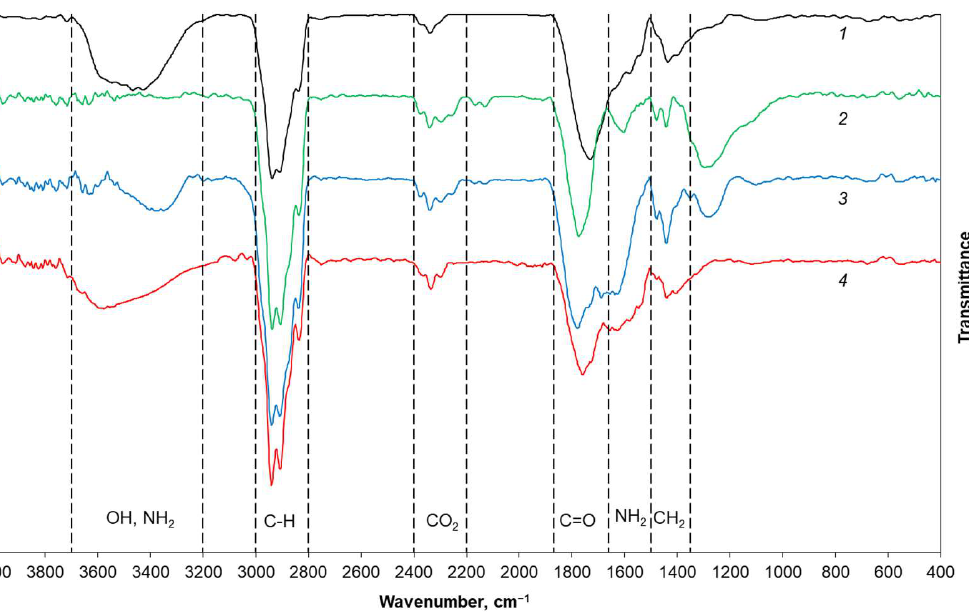
Figure 2. IR Fourier spectra of DND samples: (1) pristine DND, (2) DNDchl, (3) DNDamine, and (4) DNDamine + chl [31]. Noticeable differences are observed in the spectrum of DNDchl obtained at the first stage of chemical modification. A new broad band appears in the 1000–1300 cm − 1